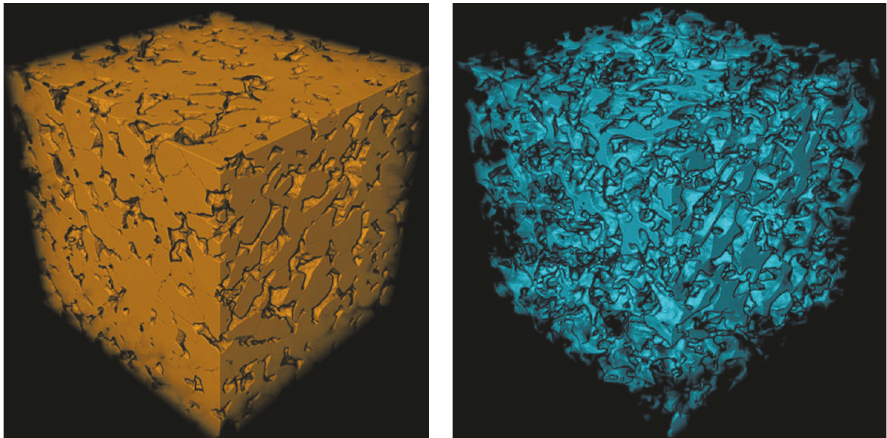
Figure 10: A 3D realization of the pore structure that can be used to construct a pore network (from http://corelab.com). Such pore network provides a reasonable approximation of the real rock sample. It can be used to determine many of the important parameters relevant to the macroscopic core sample (e.g., porosity, absolute permeability, and relative